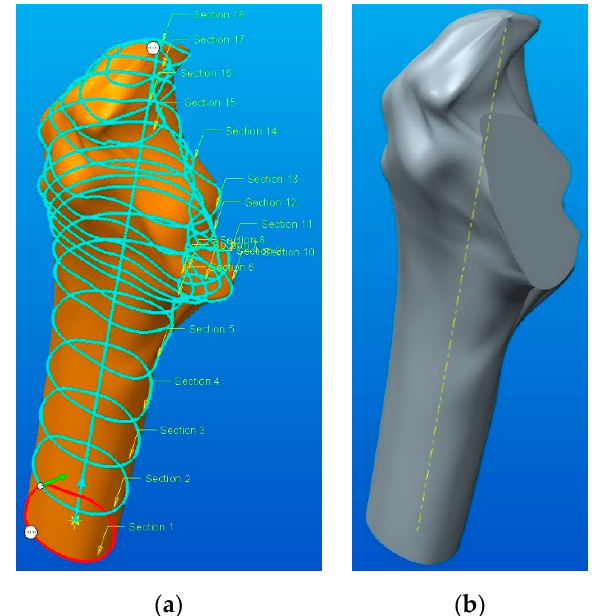
Figure 8. Tracing the parameterized 3D model: ( a ) use of the Swept Blend function; ( b ) parametrized solid model.